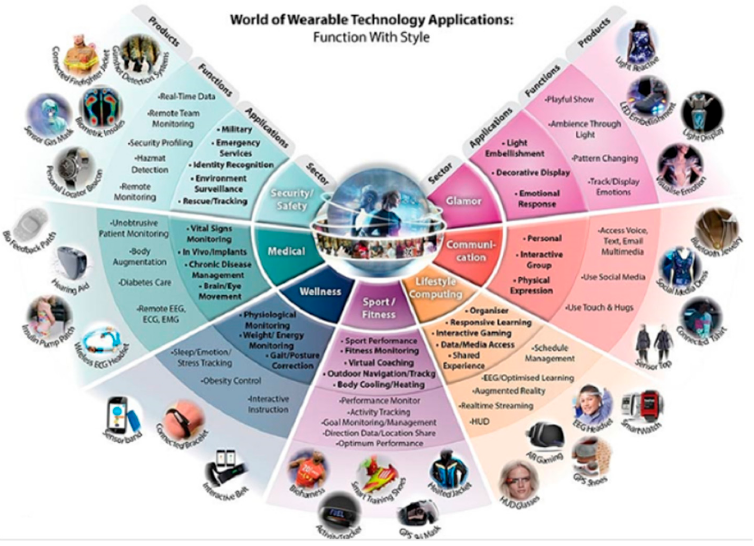
Figure 2. Expected applications in Europe for the next years